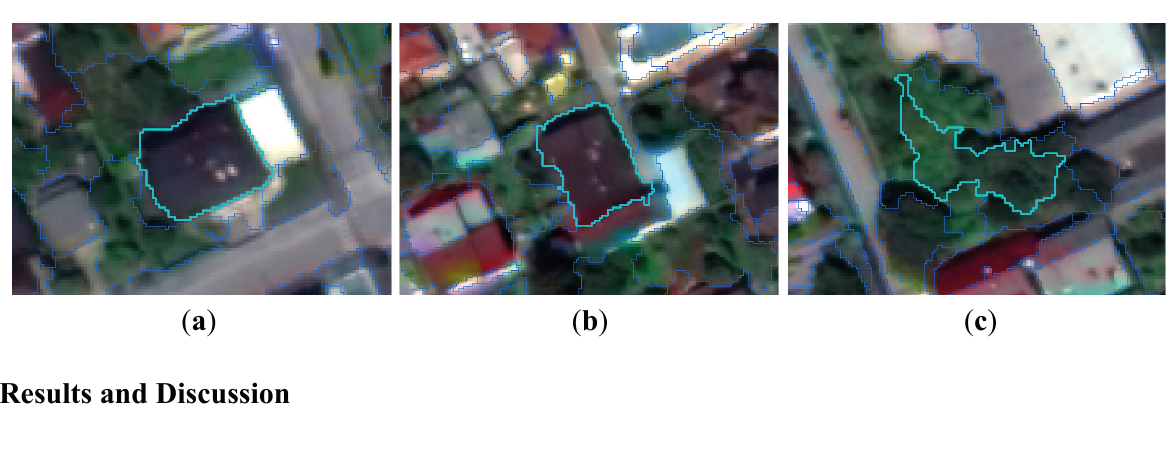
Figure 4. Segments from the segmentation layer selected for the sampling analysis: ( a ) a black roof; ( b ) a black roof; ( c ) a grass patch. Each segment contains more than 1000